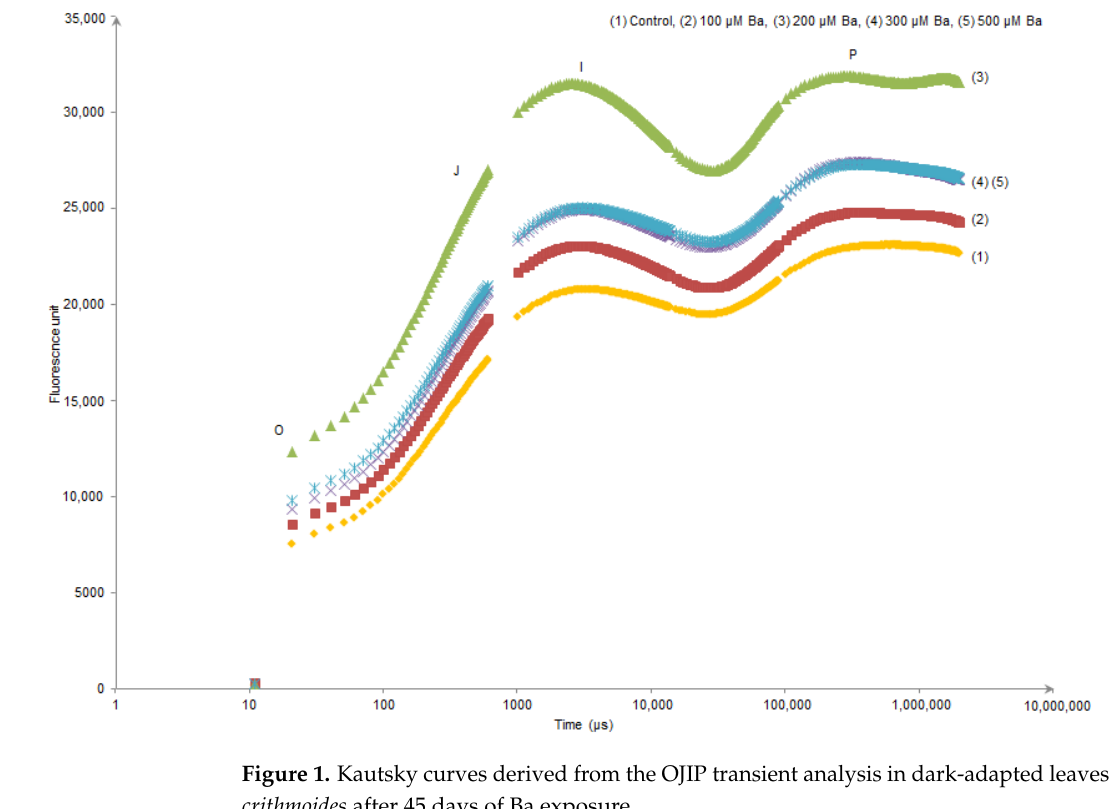
Figure 1. Kautsky curves derived from the OJIP transient analysis in dark-adapted leaves of Limbarda crithmoides after 45 days of Ba exposure.